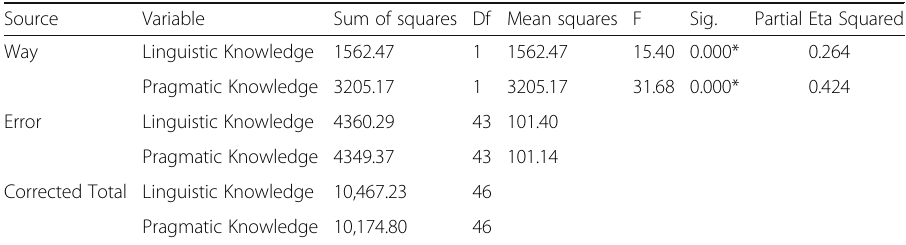
Table 4 MANCOVA of the Students ’ Scores on the Post- GST and DCT Source Variable Sum of squares Df Mean squares F